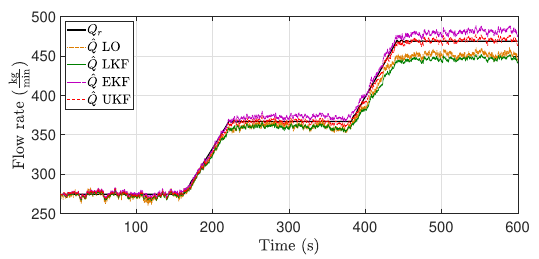
Figure 5: The varied f r and constant f Fanning friction factors.